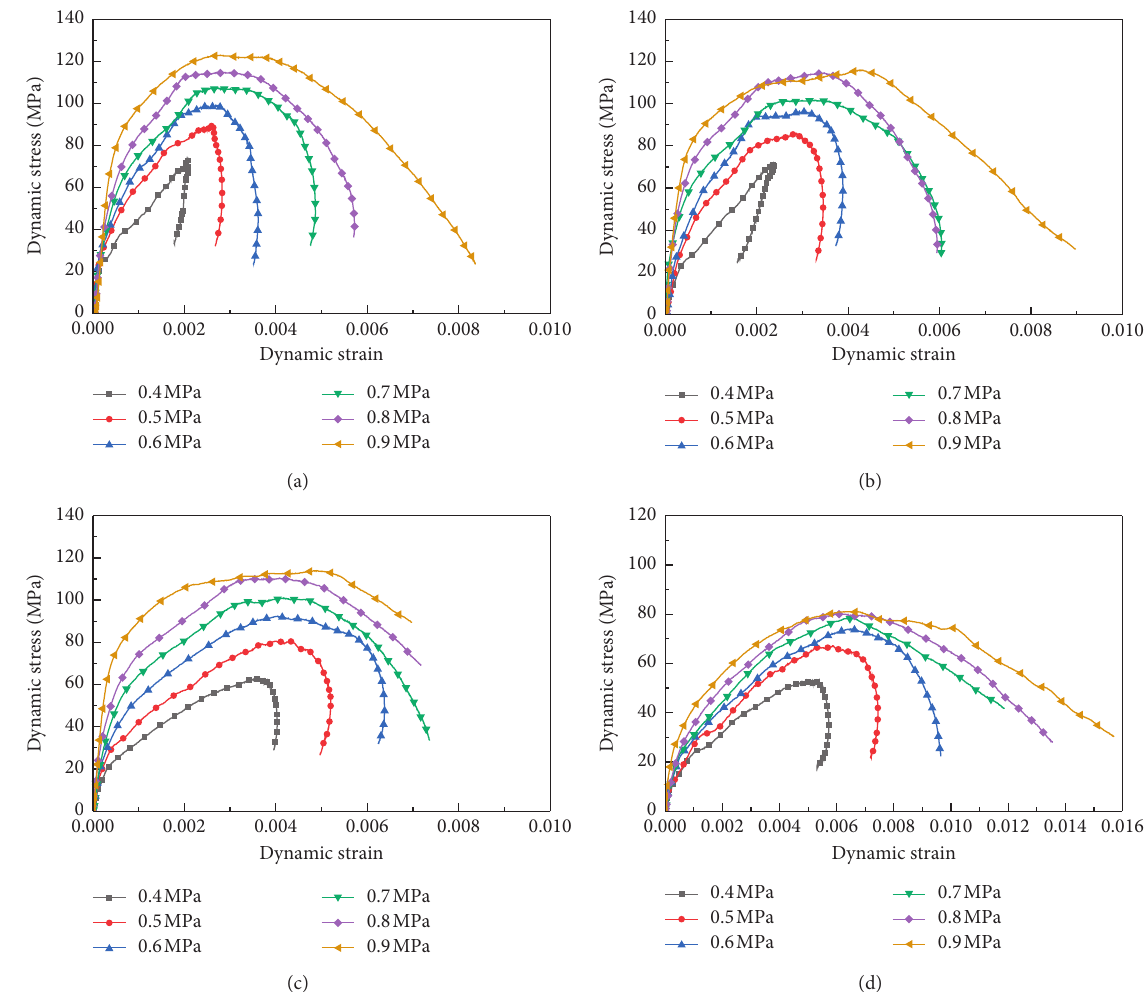
Figure 6: Dynamic compressive stress-strain curves of limestone specimen after different temperature effects. (a) 25 ° C. (b) 200 ° C. (c) 400 ° C. (d) 600 °